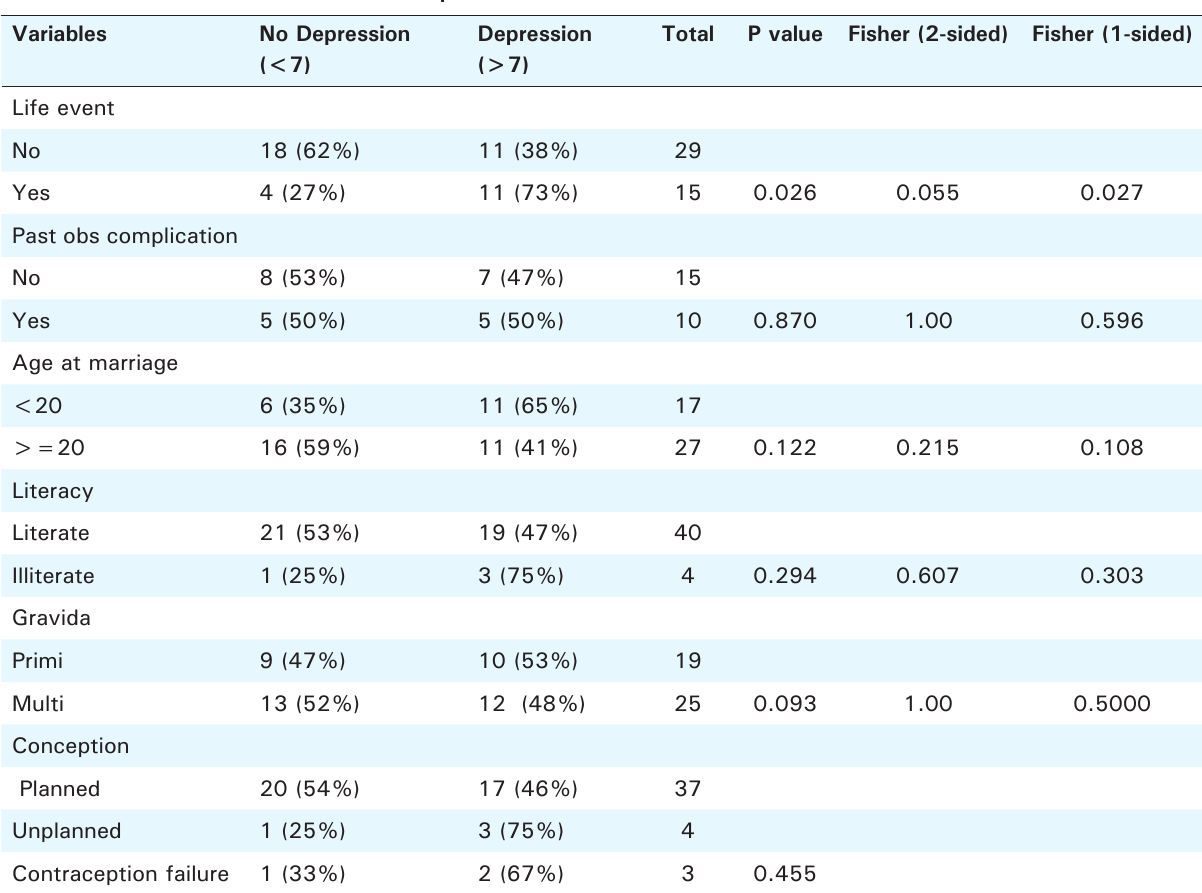
Table 2. Correlation between antenatal depression and various risk factors Variables No Depression